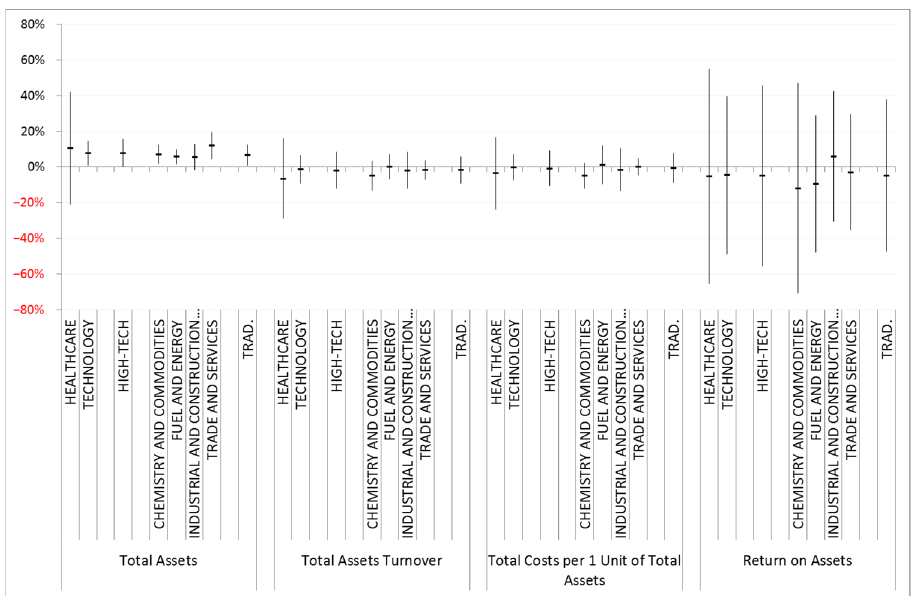
Figure 21. Typical area of variation in the area of assets in the analysed sectors. Source: own work.